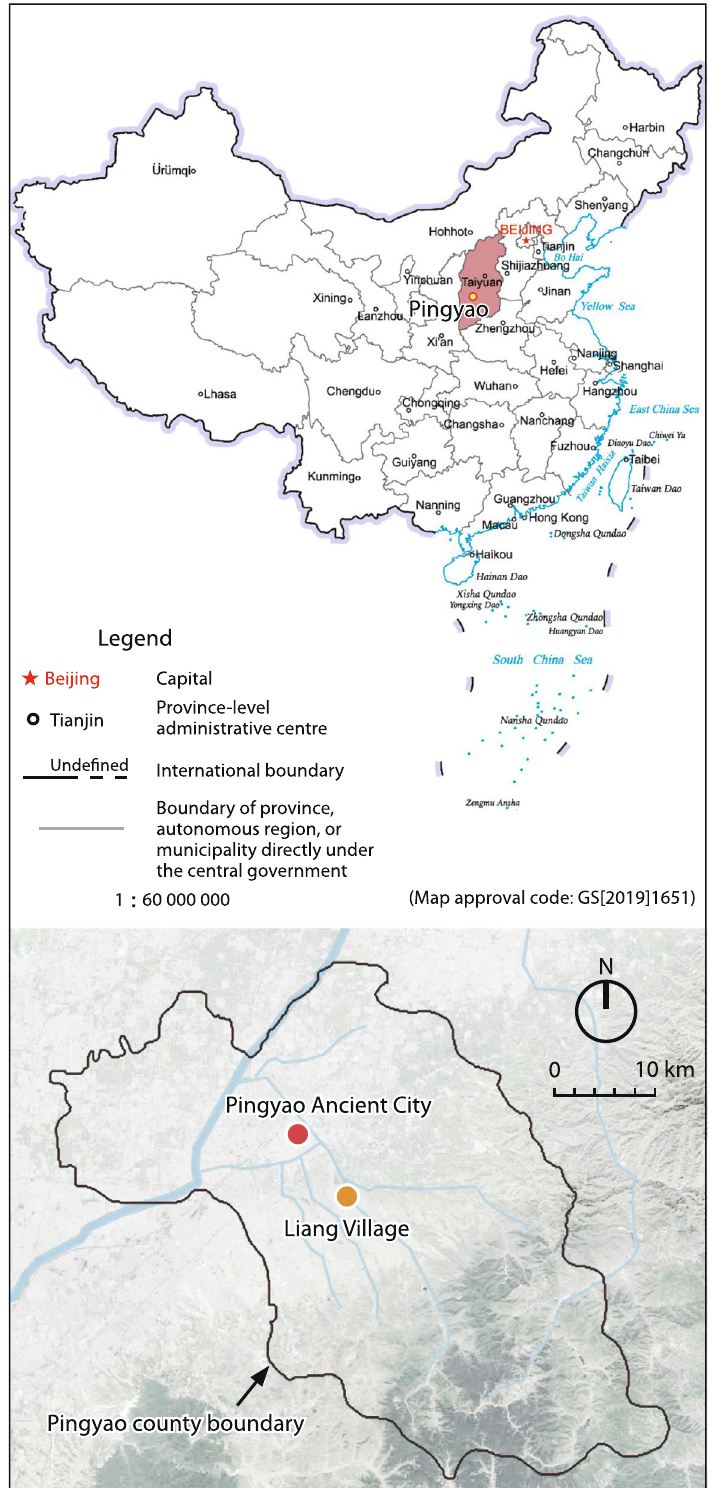
Fig. 5 Location of Liang Village (Source: the author. Background map approved by Map Vetting Centre, Ministry of Natural Resources, PRC. Map approval code: